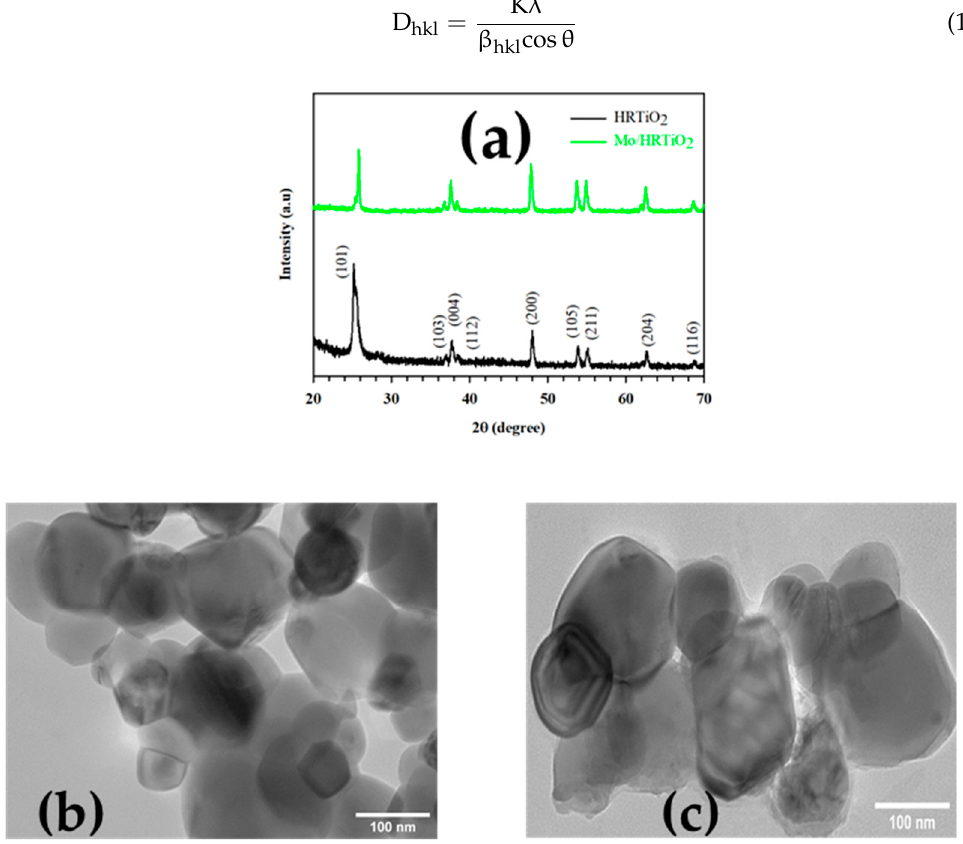
Figure 2. ( a ) XRD measurement for unmodified HRTiO 2 (black line) and Mo/HRTiO 2 (green line), TEM measurement for ( b ) unmodified HRTiO 2 , and ( c ) Mo/HRTiO 2 sample